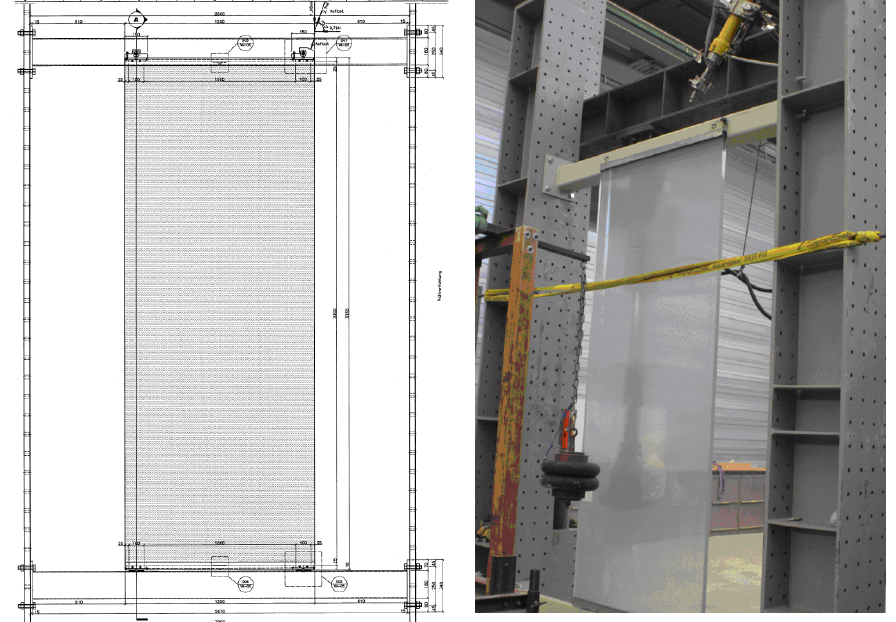
Figure 13: test set